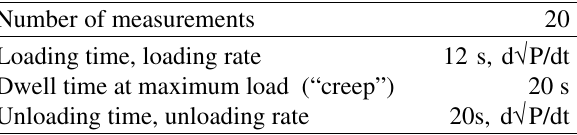
Table 1. Indentation conditions.